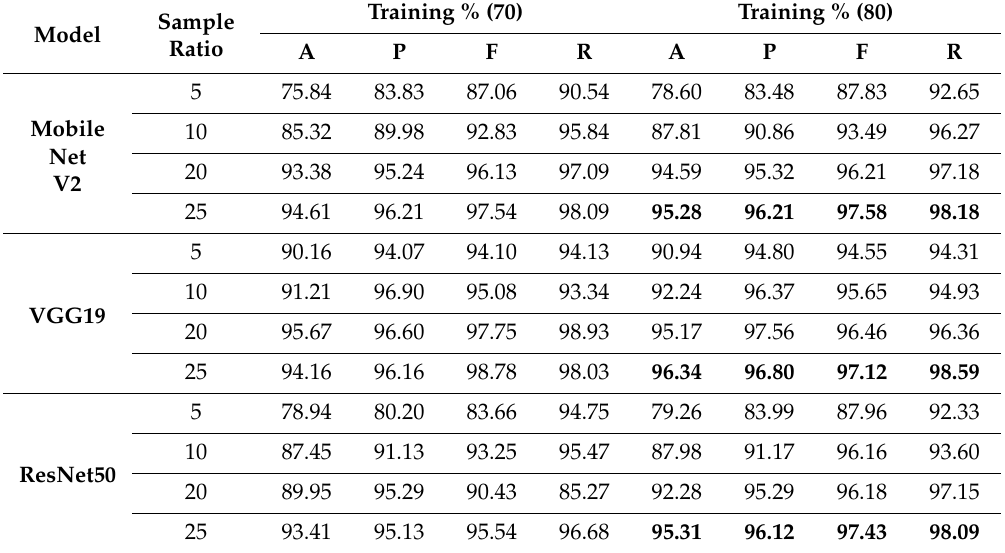
Table 6. Performance evaluation on the benchmark dataset using grayscale images.